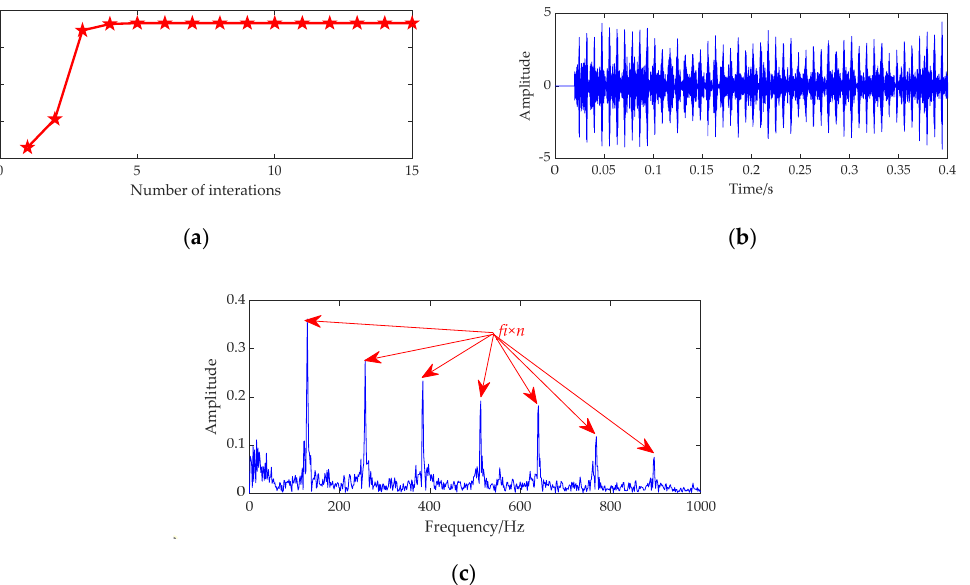
Figure 8. Inner ring fault feature extraction using CLNGO-MNAD. ( a ) Convergence curve of SPC. ( b ) Time-domain waveform. ( c ) Envelope spectrum.